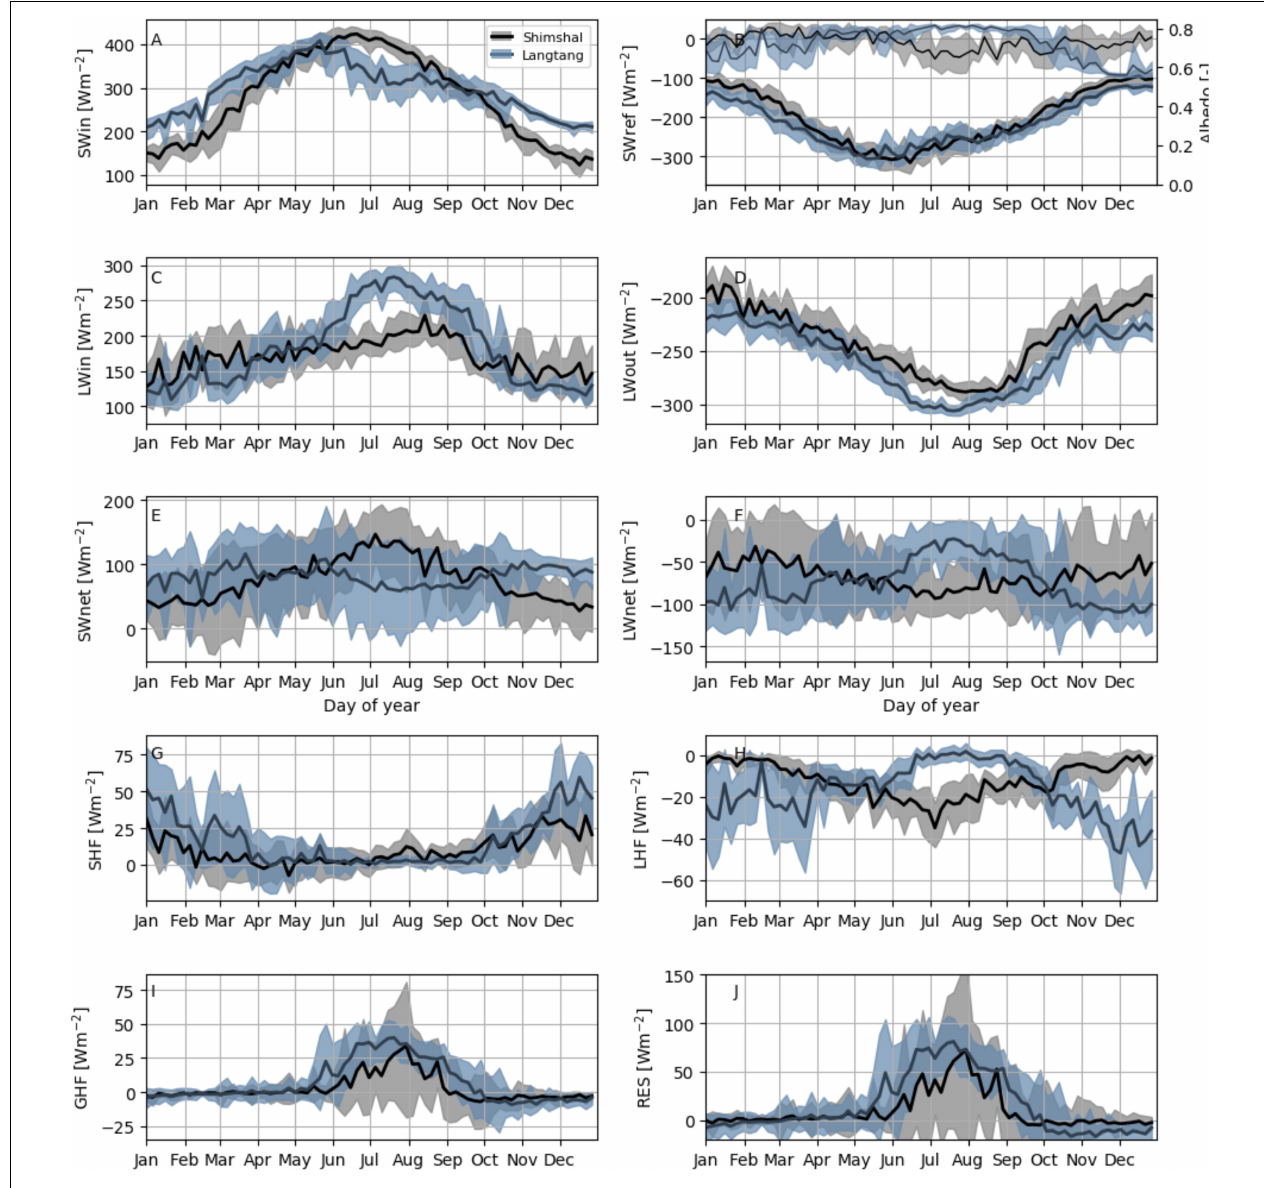
FIGURE 6 | The surface energy balance (SEB) components, 5-day averaged, 3-years average for the glacierized cells in Shimshal (black) and Langtang (blue). The shading indicates the lowest and maximum value of the individual year. SWin (A) and LWin (C) are the short and longwave incoming radiation components, SWref (B) and LWout (D) the shortwave reflected and longwave outgoing radiation components, and SWnet (E) and LWnet (F) the net radiation components. SHF (G) , LHF (H) , and GHF (I) are the sensible, latent, and ground heat flux, respectively. The albedo is plotted in panel (B) (thin lines). The residual term (RES, Panel J ) is calculated as SWnet + LWnet + SHF + LHF +